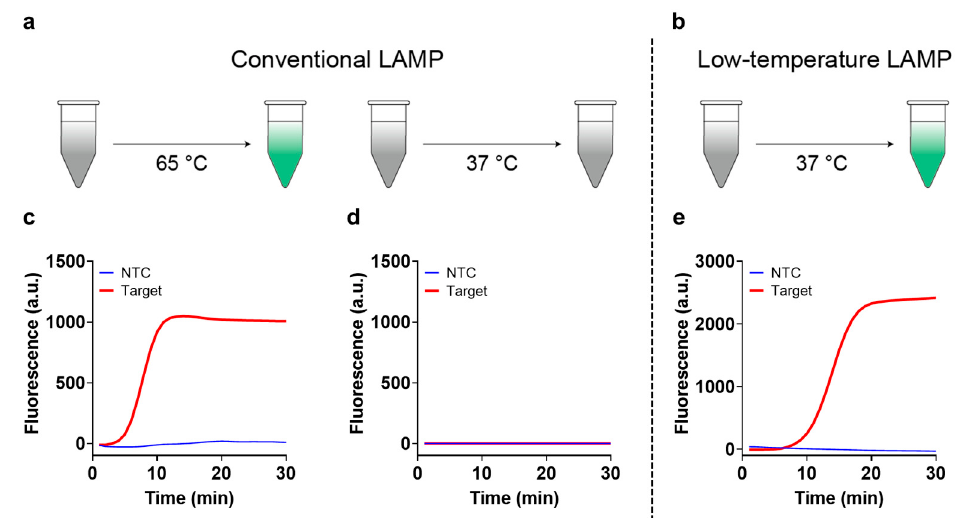
Figure 2. Comparison of conventional and low-temperature LAMPs. Schematic illustration describing the reaction results of the conventional ( a ) and low-temperature LAMP ( b ) methods at different temperatures (65 and 37 °C, respectively). The gray and green colors indicate the negligible and strong fluorescence signals of SYBR Green I, respectively. The amplification curves of the conventional LAMP reaction were obtained at ( c ) 65 °C and ( d ) 37 °C. NTC and Target indicate the absence and presence of C-SLP (50 pM), respectively. ( e ) The amplification curve of the low-temperature LAMP reaction obtained at 37 °C. NTC and Target indicate the absence and presence of RL15 (50 pM), respectively. All tests were performed with three technical replicates.